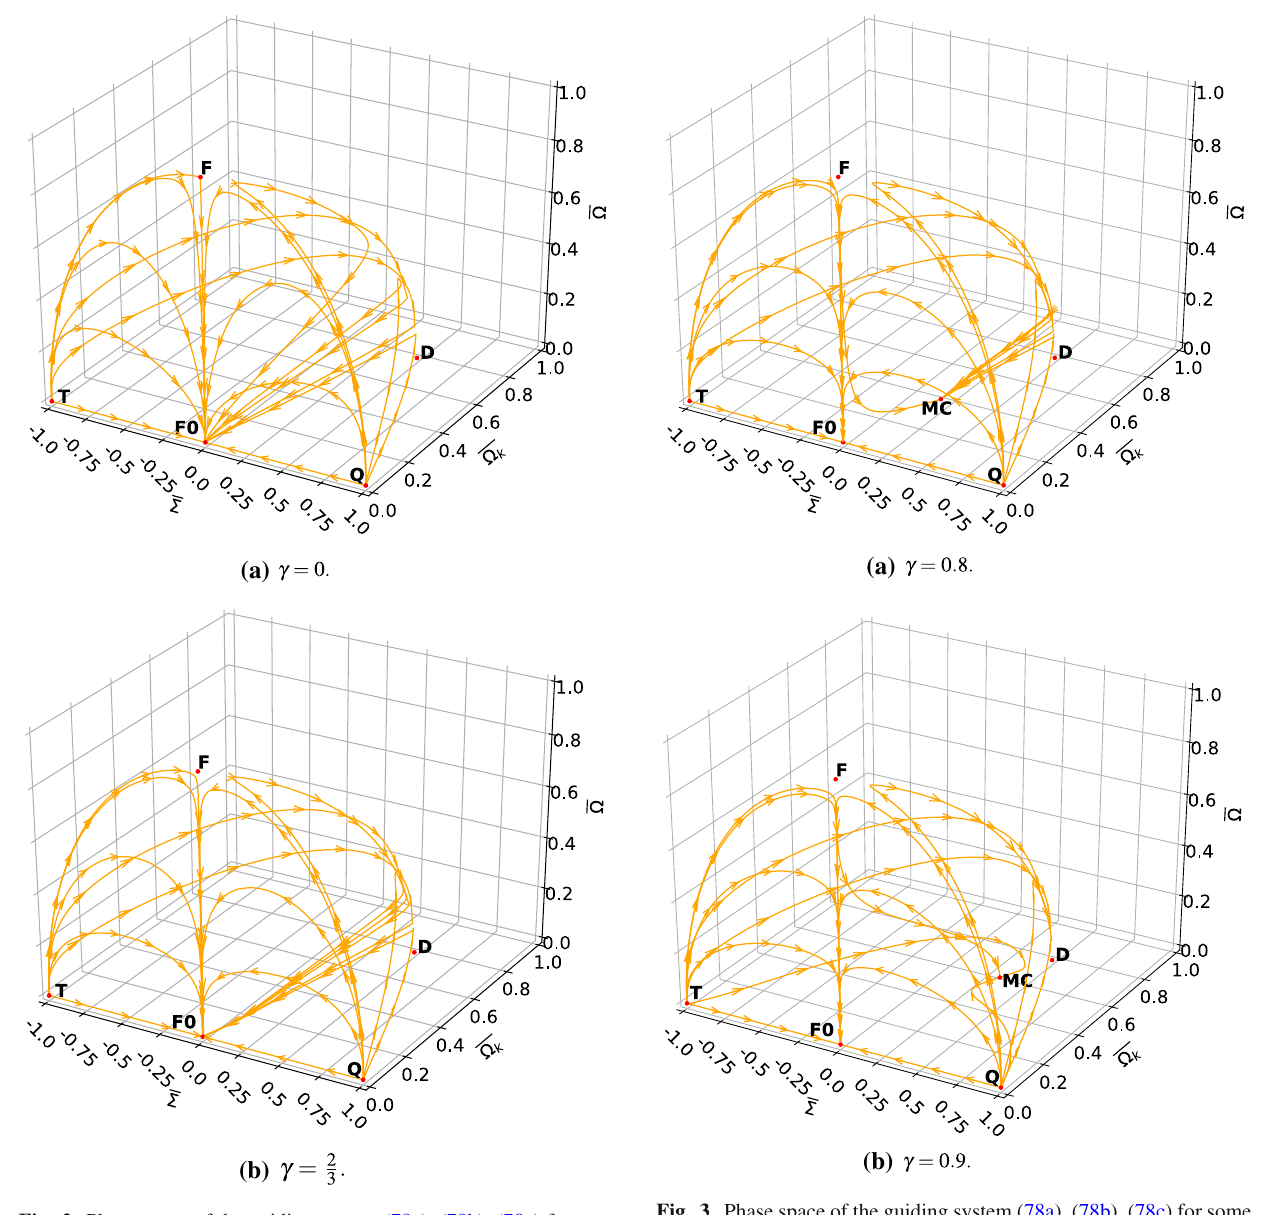
fold analysis in Appendix B.2. For γ = 2 the line connecting T , F 0 , Q is invariant and